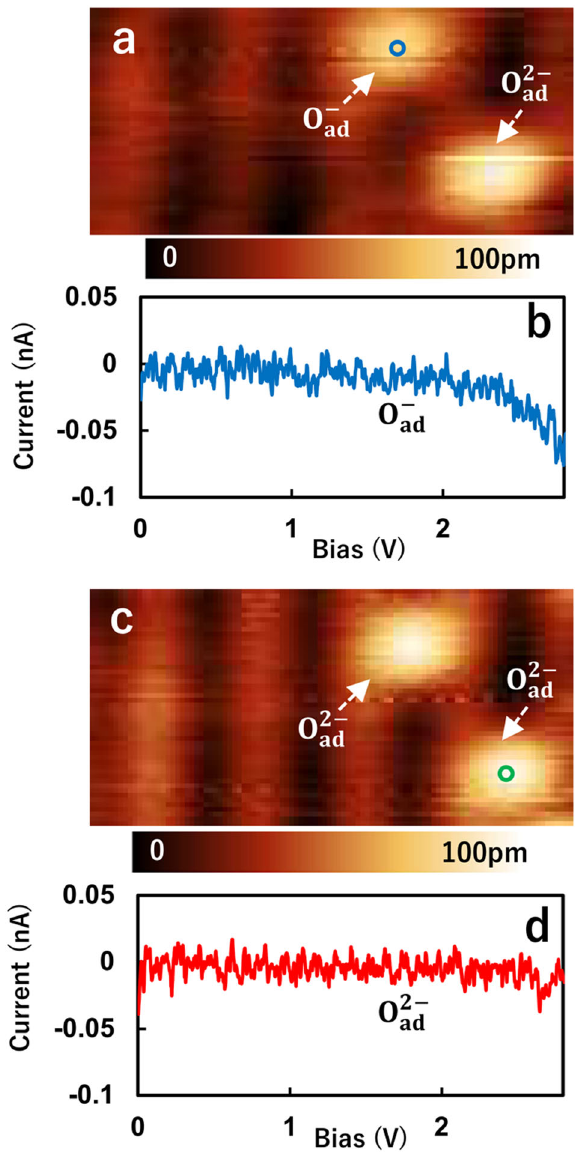
Fig. 2 Measured O ad conductance. a , c AFM images of the TiO 2 surface showing O atoms in both redox states prior to current measurements (the constant Δ f mode, zero bias). This experiment was carried out at larger tip- sample distances than those used in Fig. 1 and at positive biases. b The current measured by placing the tip above the O (cid:1) ad species as indicated by the dot in ( a ). d The current measured by placing the tip above the O 2 (cid:1) ad species as indicated by the dot in ( c ). During the measurements, the feedback loop was switched off, and the sample bias was ramped from zero in the direction of the positive